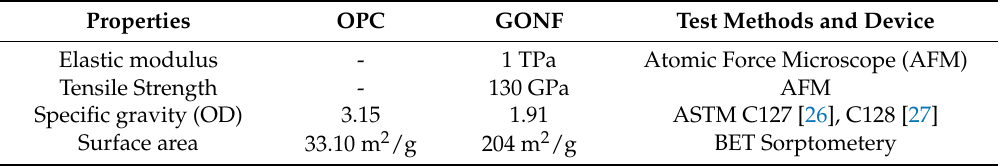
Table 4. Basic physical properties of materials, standard test methods and